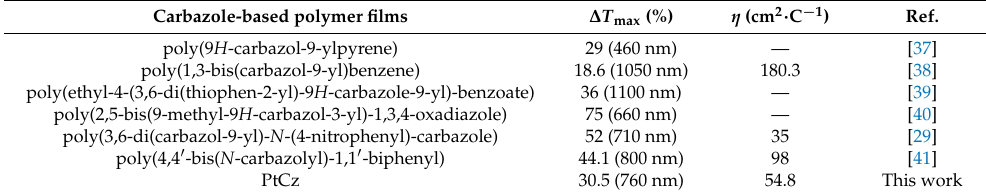
Table 4. Optical contrasts and coloration efficiencies of carbazole-based polymer films. Carbazole-based polymer films